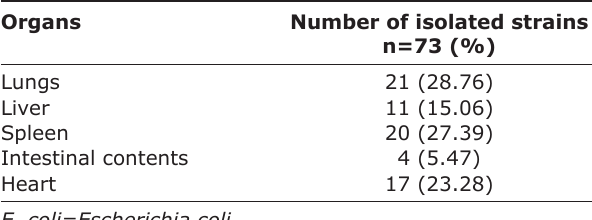
Table-1: Number of strains of avian pathogenic E. coli isolated from different samples.